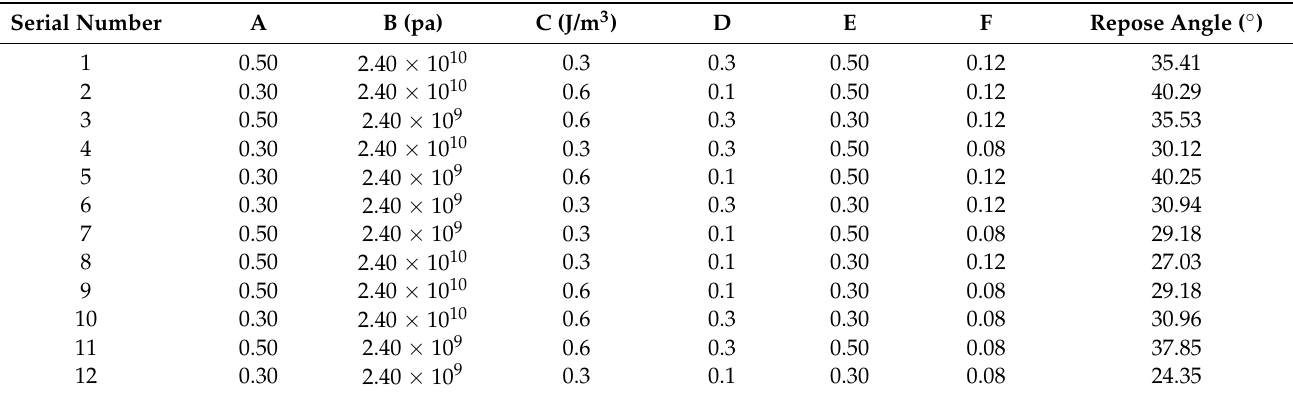
Table 2. Design and results of Plackett-Burman test.